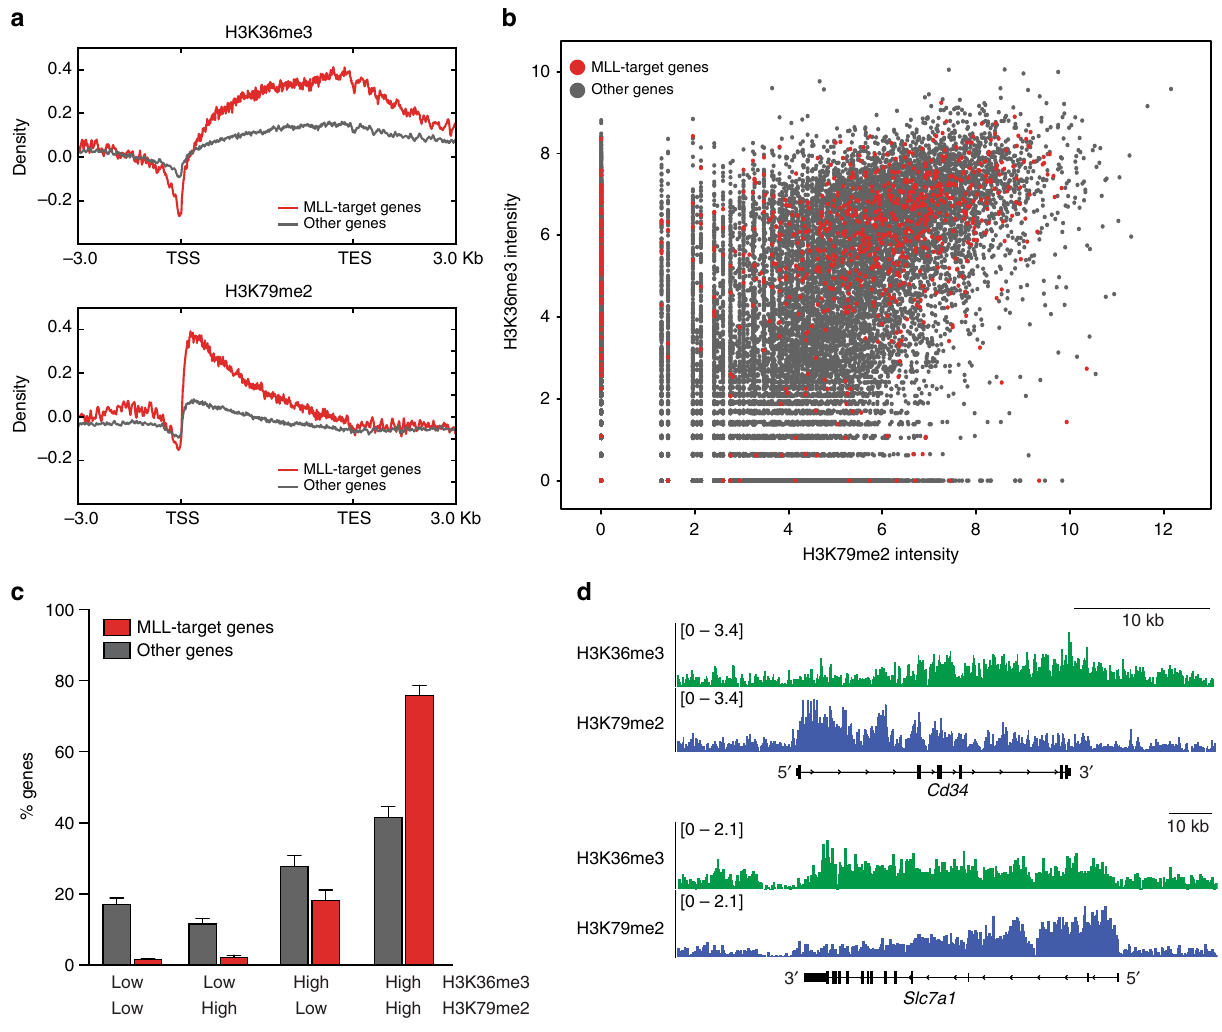
Fig. 4 MLL-target genes are marked by a H3K36me3-H3K79me2 signature. a Metagene plots of ChIP-Rx data for H3K36me3 (top) and H3K79me2 (bottom) for MLL-target genes (red) or non-MLL-target genes (gray) in mouse MLL-AF9/Nras G12D AML cells. b Dot plot of normalized ChIP-Rx signal intensities for H3K36me3 vs. H3K79me2 marks on MLL-target genes (red) or non-MLL-target genes (gray) in the mouse genome (Pearson R = 0.44, p < 2.2 × 10 − 16 ). c Bar graph showing percentages of genes among MLL-target genes and non-MLL-target genes associated with the indicated histone marks; low: not exceeding input counts per gene, high: exceeding input counts per gene (mean ± s.d. n = 2). d H3K36me3 (green) and H3K79me2 pro fi les (blue) of selected MLL-AF9-target